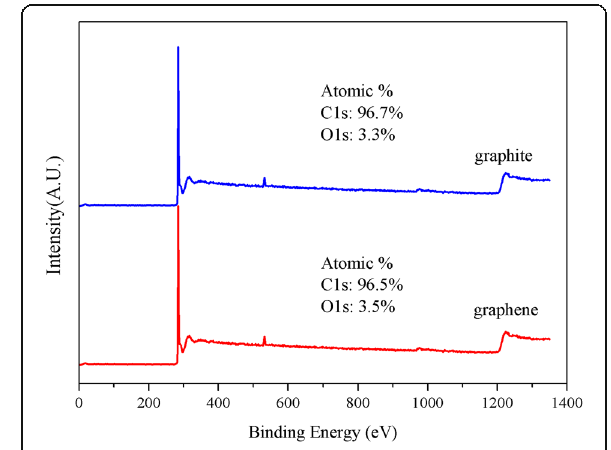
Fig. 6 Raman spectroscopy of the bulk graphite and graphene Fig. 7 XPS spectra of the bulk graphite and